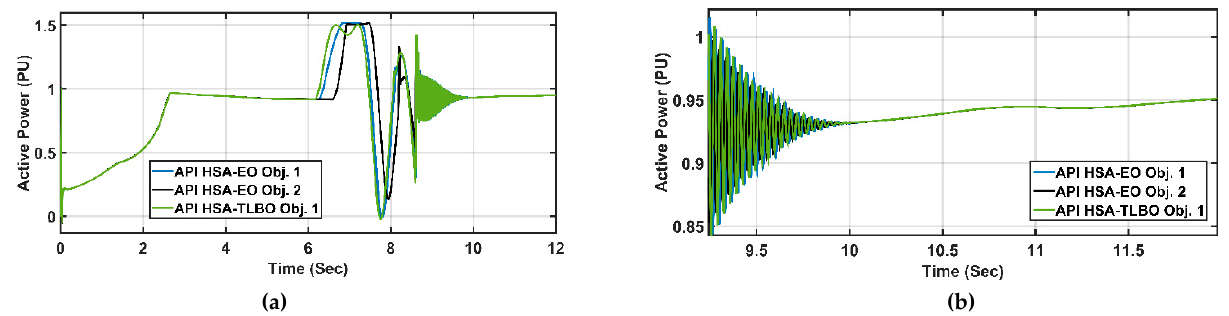
Figure 21. Wind-speed profile of normal fourth case.